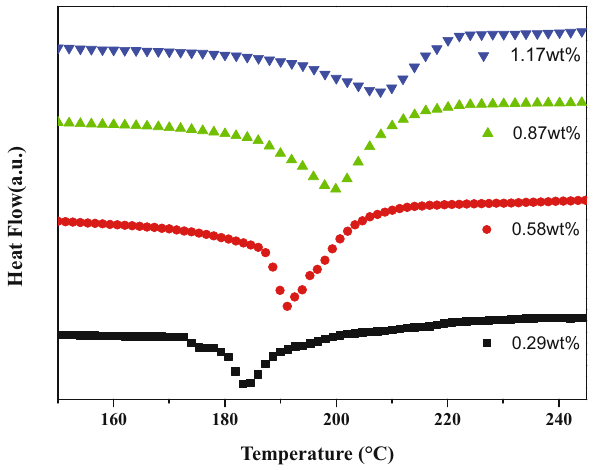
Figure 4: DSC curves of di ff erent crosslinking agent content microspheres